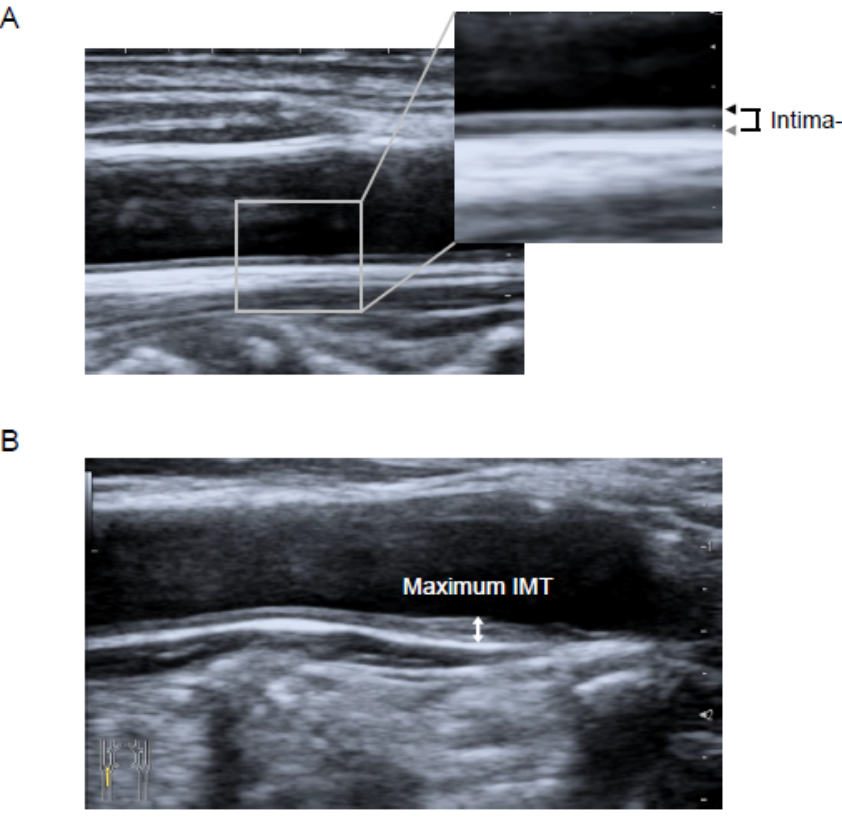
Figure 2. Longitudinal B-mode ultrasonographic images of the common carotid artery. ( A ) Intima-media thickness (IMT) was measured as the distance between the lumen-intima interface (black arrow) and the media-adventitia interface (gray arrow). ( B ) The maximum IMT was recorded as the largest IMT value measured on both sides of the common carotid artery, carotid bulb, and internal carotid artery (two-headed arrow). Abbreviation—IMT, intima-media thickness.